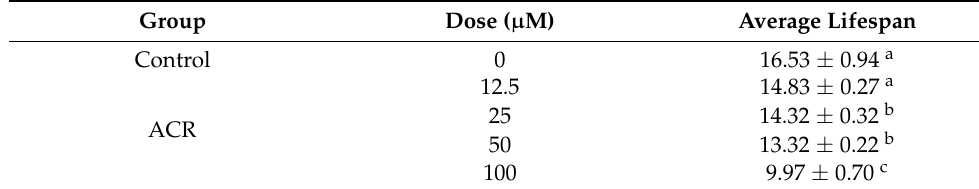
Values represent mean ± standard deviations. Significant differences ( p < 0.05) in the same column were expressed by using different letters ( a , b , c